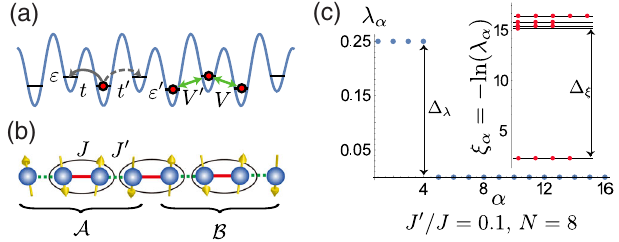
FIG. 3. Entanglement spectrum of the extended 1D Hubbard model supporting symmetry-protected topological order in the ground state. (a) Optical lattice with a two-site unit cell corresponding to the Hamiltonian (8). The Hubbard parameter alternate between even and odd sites t 2 j ≡ t , t 2 j − 1 ≡ t 0 , and analogously for ε j and V j . (b) In the hard-core boson regime, this can be mapped to an alternating-bond spin- 1 = 2 Heisenberg model (9), with J ¼ t= 2 ¼ V= 4 and J 0 ¼ t 0 = 2 ¼ V 0 = 4 (see Appendix C). The strong antiferromagnetic bond (red) favors the formation of a spin-singlet dimer in the small J 0 =J limit. (c) ES λ α of a bipartite split of regions A and B , and corresponding entanglement energies ξ α ¼ − ln ð λ α Þ (inset) ( J 0 =J ¼ 0 . 1 , on N ¼ 8 sites), for one of the four degenerate ground states of Eq.